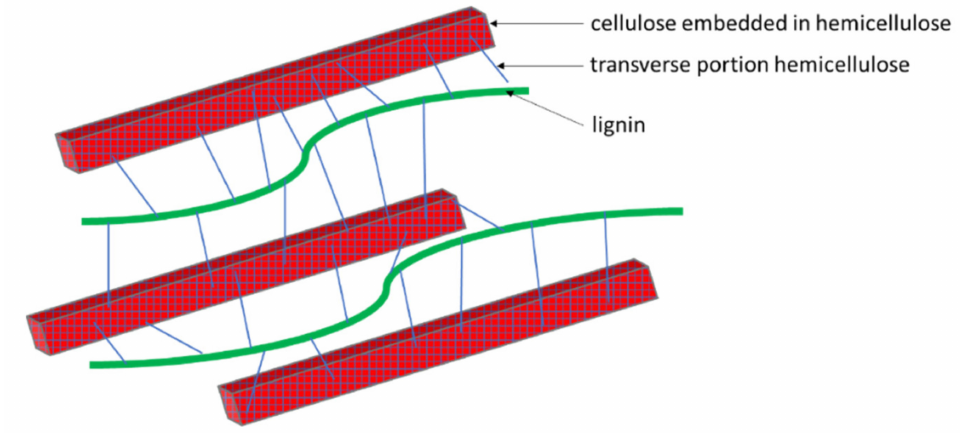
Figure 2. Schematic representation of the microstructure of lignocellulosic plant cell walls (hemicellulose—blue, cellulose—red, lignin—green)